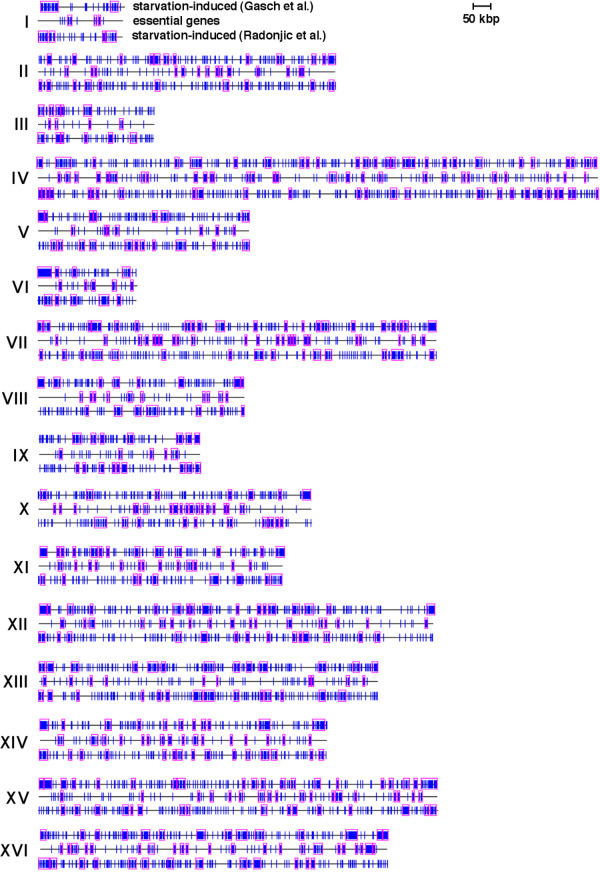
Most genes essential for growth map between clusters of starvation-induced genes. Vertical blue lines indicate the position of genes in starvation-induced or essential gene datasets. Pink rectangles indicate clusters of genes detected by Pyxis that are unlikely to have formed by chance (p ≤ 0.05). Roman numerals indicate chromosome number.